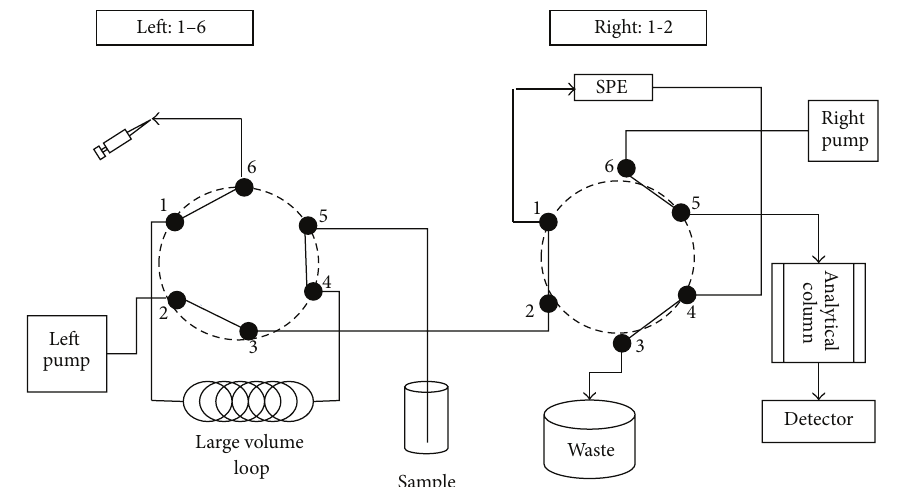
Figure 1: Left- and right-valve positions with the ports (1-6)